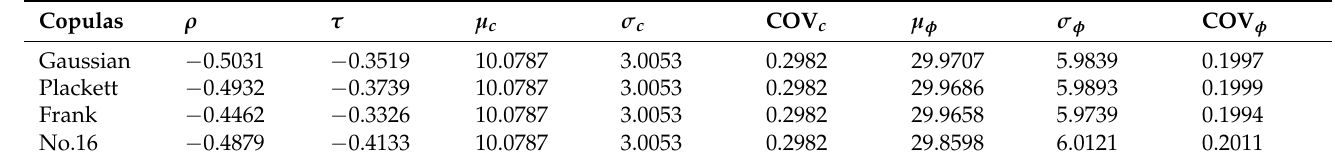
Table 4. Statistics of CCRF variables associated with candidate